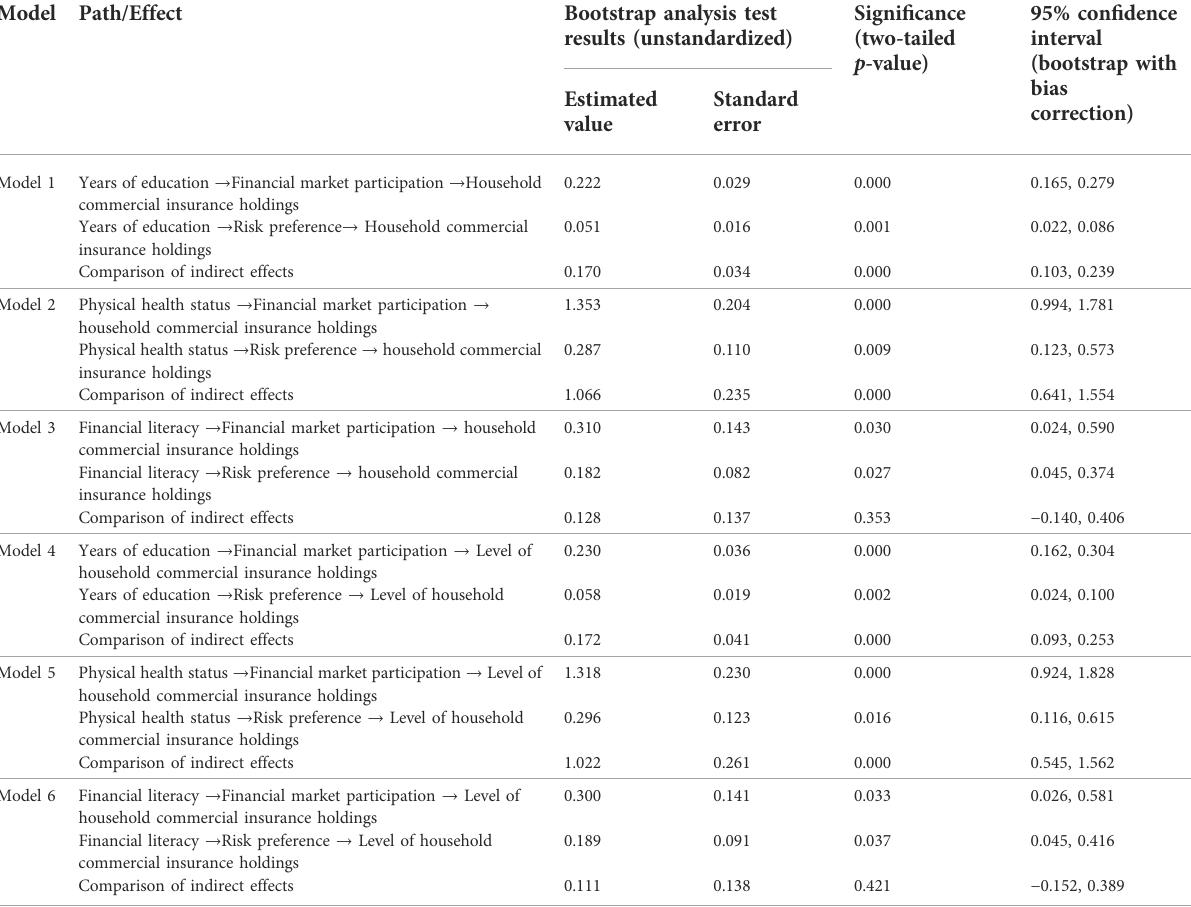
TABLE 4 Results of the Bootstrap test analysis for the signi fi cance of mediation. Model